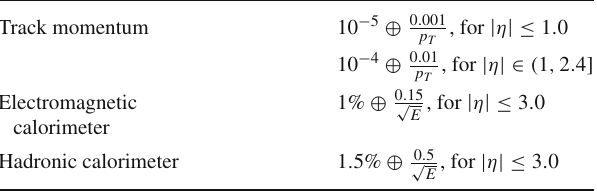
), electromagnetic T